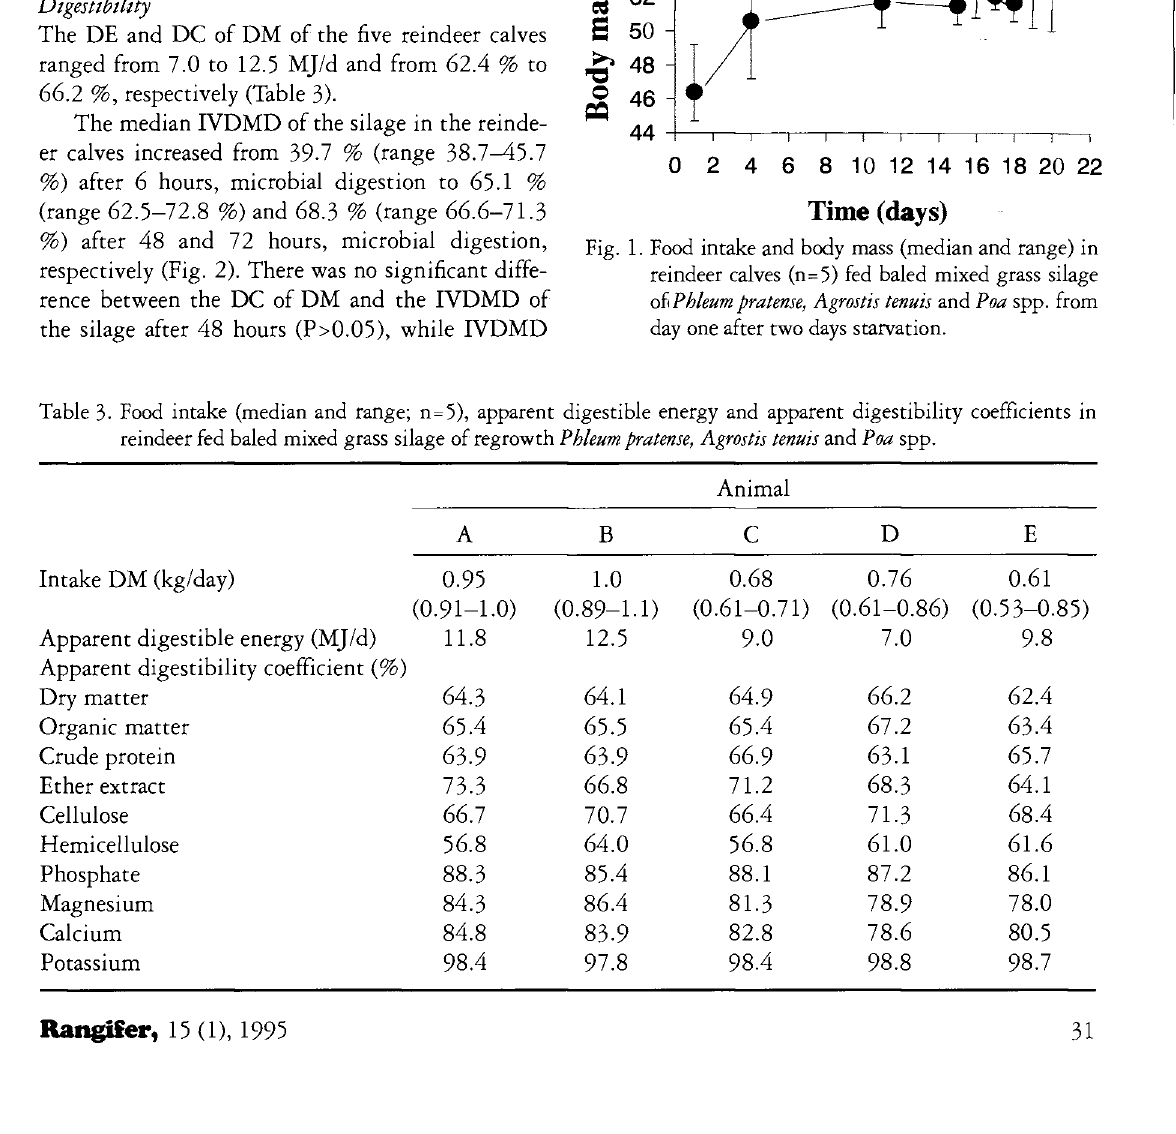
Table 3. Food intake (median and range; n = 5), apparent digestible energy and apparent digestibility coefficients